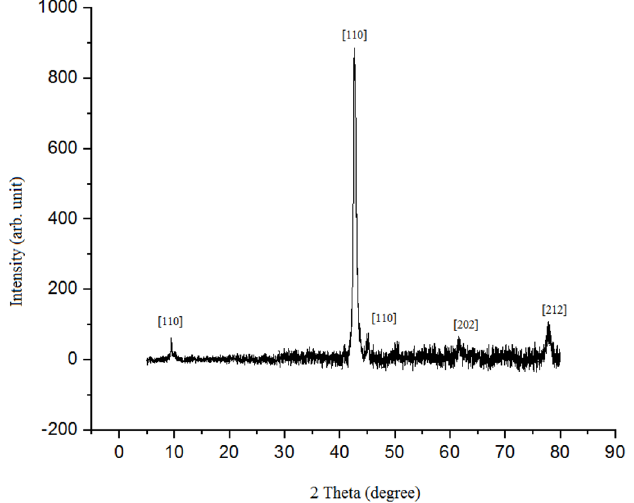
Fig. 1. XRD pattern in Ni 49 Fe 1 Mn 30 Sn 18 In 2